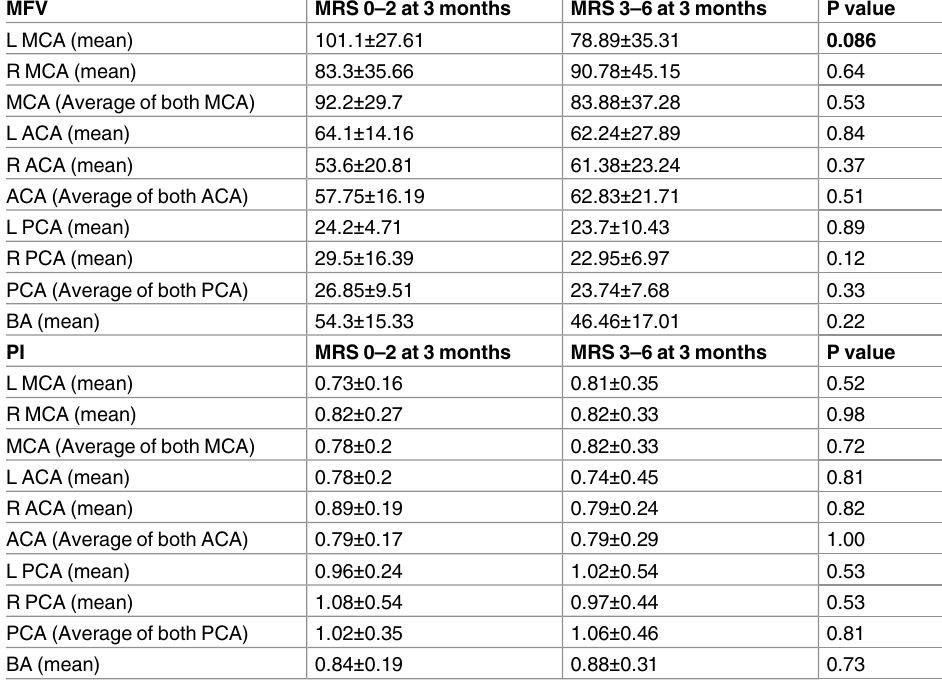
Ten (27.8%) patients achieved good outcome (mRS 0–2) at 3 months, which increased to 13 (36.1%) at 6 months. The comparison of Vmean and PI between the patients who had func- tional outcome (mRS) at 3 and 6 months is shown in Tables 4 and 5. There was also a signifi- cant difference between good and poor outcome for Vmean of left MCA (p = 0.086) at 3 Table 4. Mean flow velocities and pulsatility index correlation with Modified Rankin scale (MRS) at 3 months. ACA-anterior cerebral artery; BA- basilar artery; MCA-middle cerebral artery; PCA- posterior cere- bral